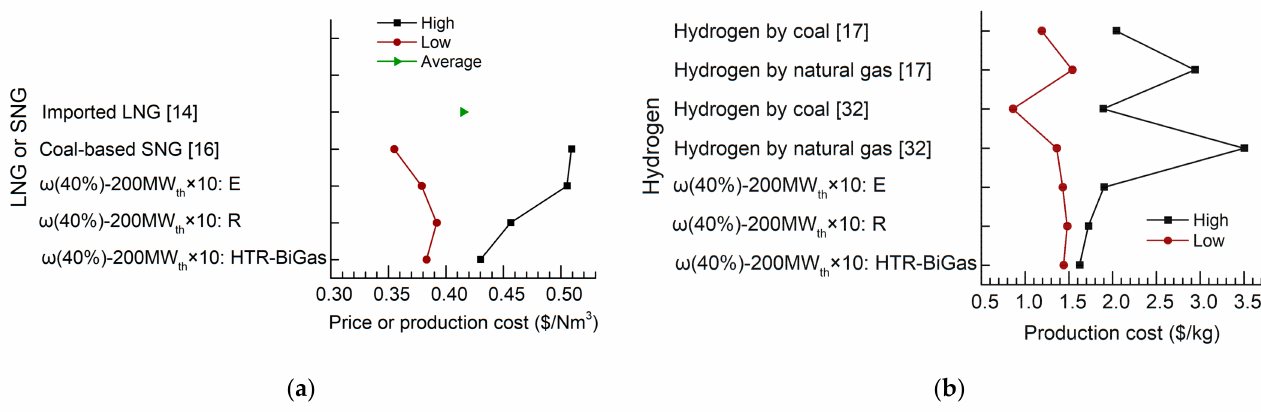
Figure 5. Production costs or prices of natural gas and hydrogen of HTR-BiGas, related designs, mainstream production techniques and imported LNG. ( a ) Prices or production costs of SNG or LNG; ( b ) production costs of hydrogen. LNG: liquefied natural gas; SNG: synthetic natural gas; ω : moisture content of biomass; E: electric auxiliary heating; R: increasing recirculated product gas; HTR-BiGas: high-temperature gas-cooled reactor biomass gasification; prices of coal and natural gas are 61.7–123.4 $/t and 0.309–0.617 $/Nm 3 , respectively [17]; prices of electricity are 0.06–0.15 $/kWh for HTR-BiGas and related